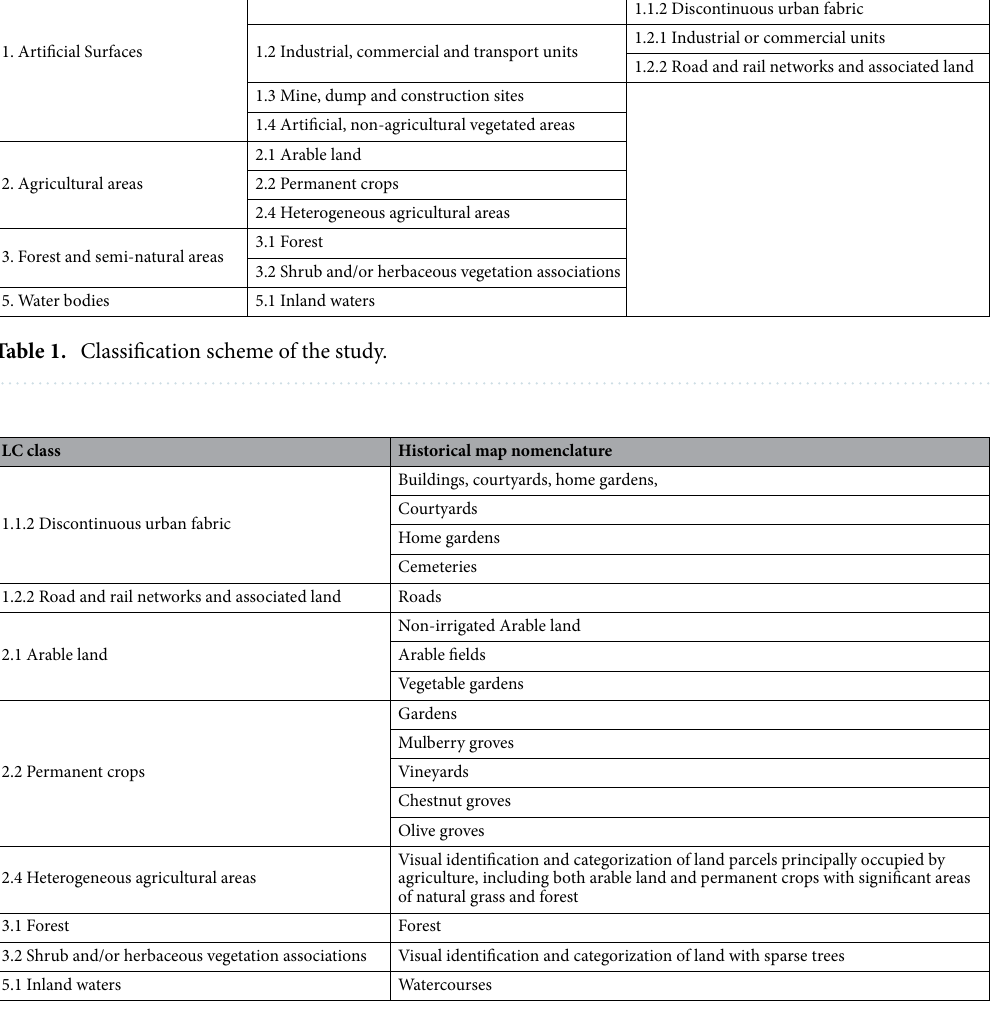
Table 2. Correspondence between Corine Land Cover and historical cadastral maps